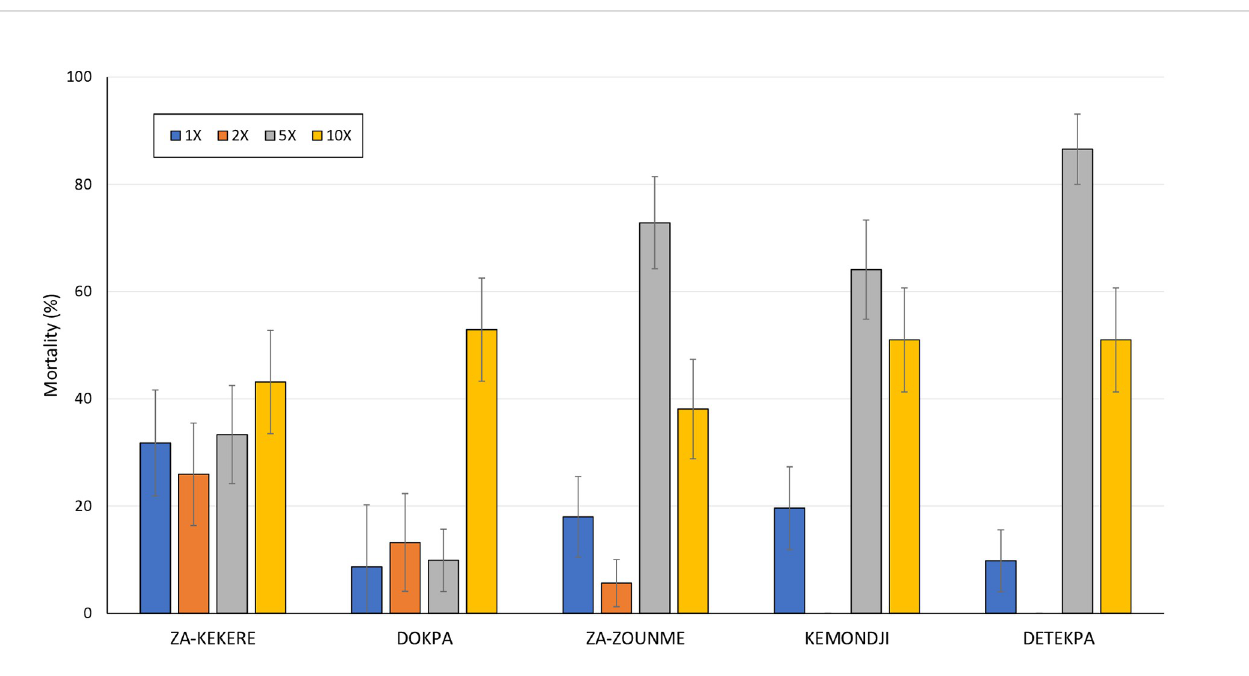
Fig 4. Mortality (24h) deltamethrin 1X, 2X, 5X and 10X in bottle bioassays with wild An . gambiae s.l. from 5 villages of Za-Kpota sub-district, southern Benin.